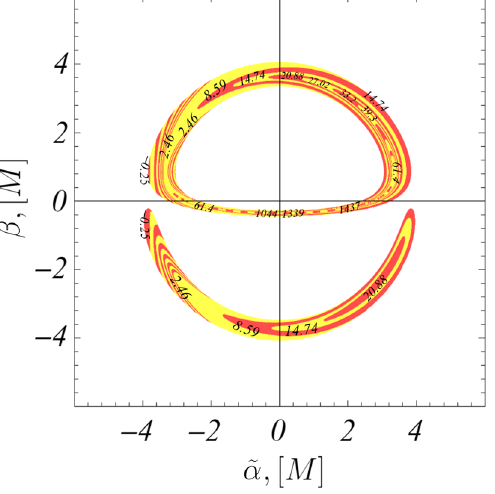
Fig. 18 Curves of constant redshift z for the outer disk of the strongly naked singularity with γ = 0 . 48 (left), and the Schwarzschild black hole (right). The observer is located at r obs = 5000 M , and at the inclination angle i = 80 ◦ . The value of the relevant redshift is specified on each contour